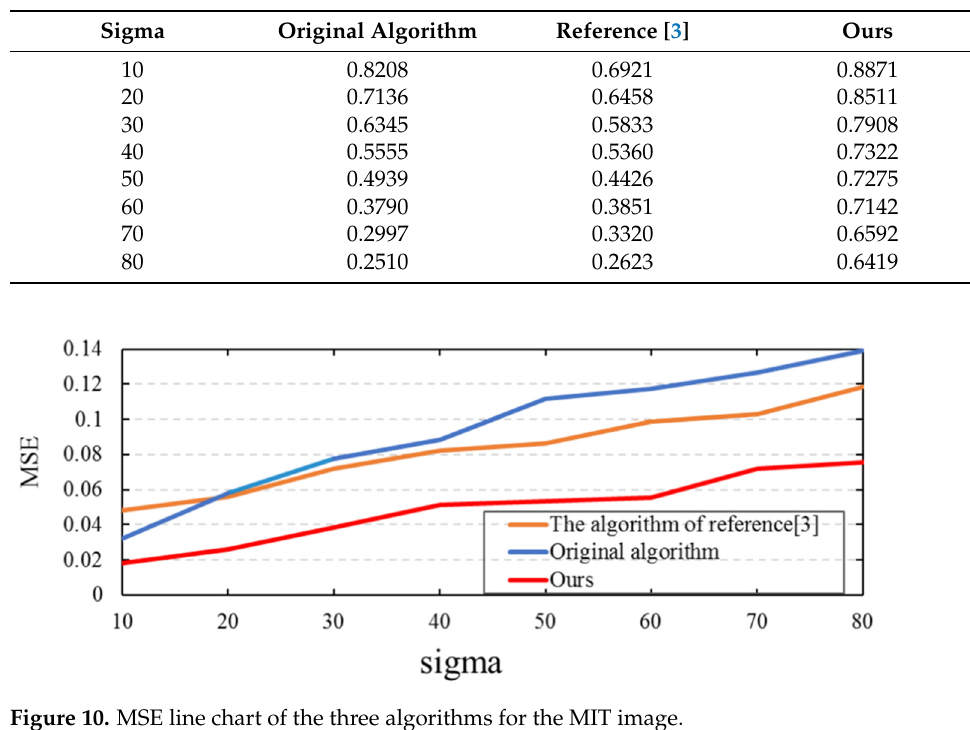
Table 9. SSIM of the three algorithms for the MIT image.